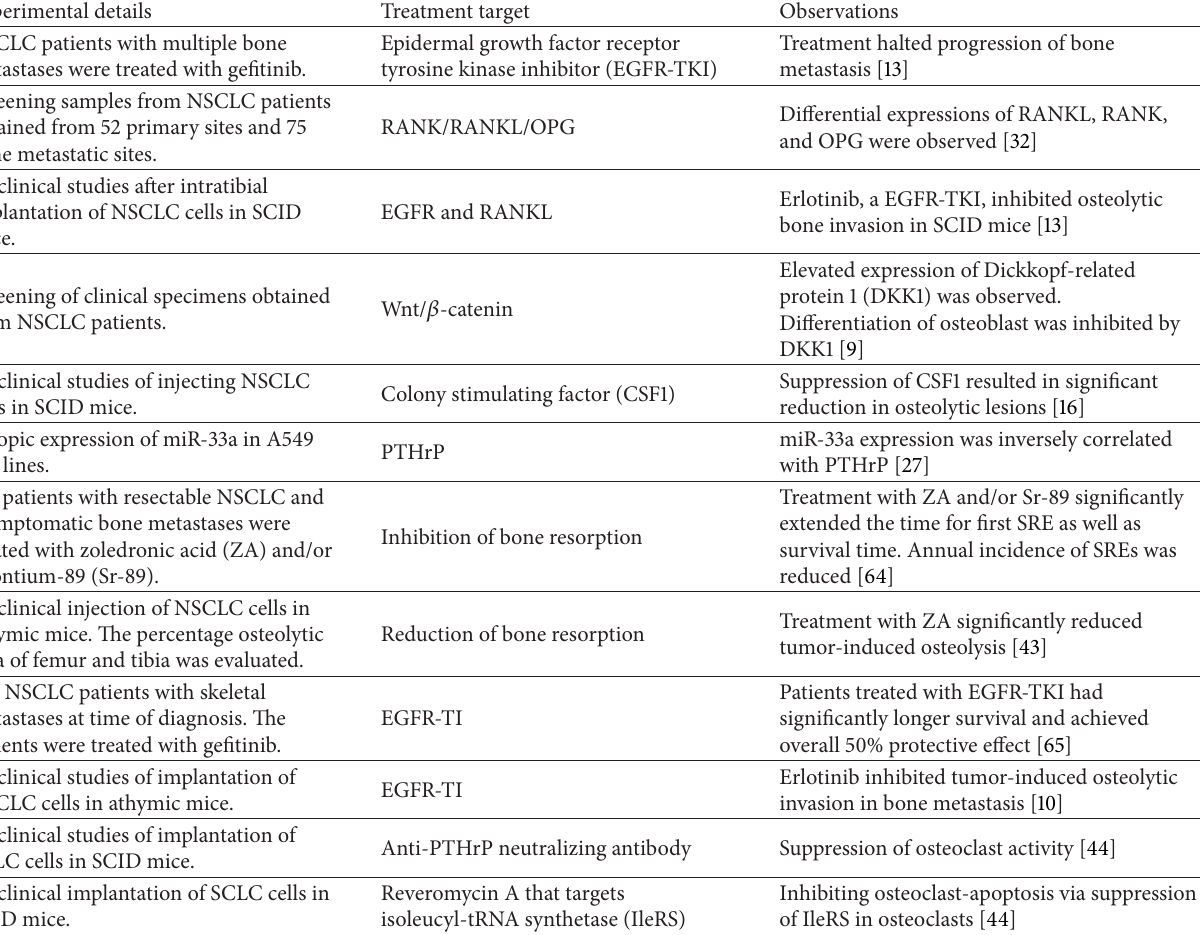
Table 1: Examples of lung cancer therapeutic strategies that are based on bone